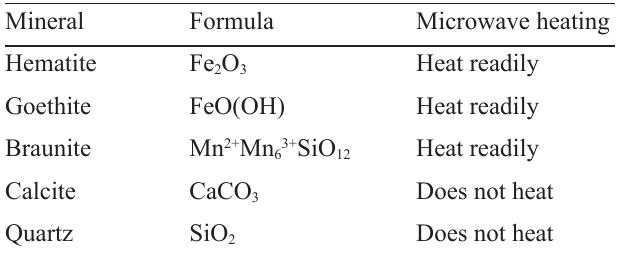
Table 2. Heating properties of minerals with microwave radiation [18,19].